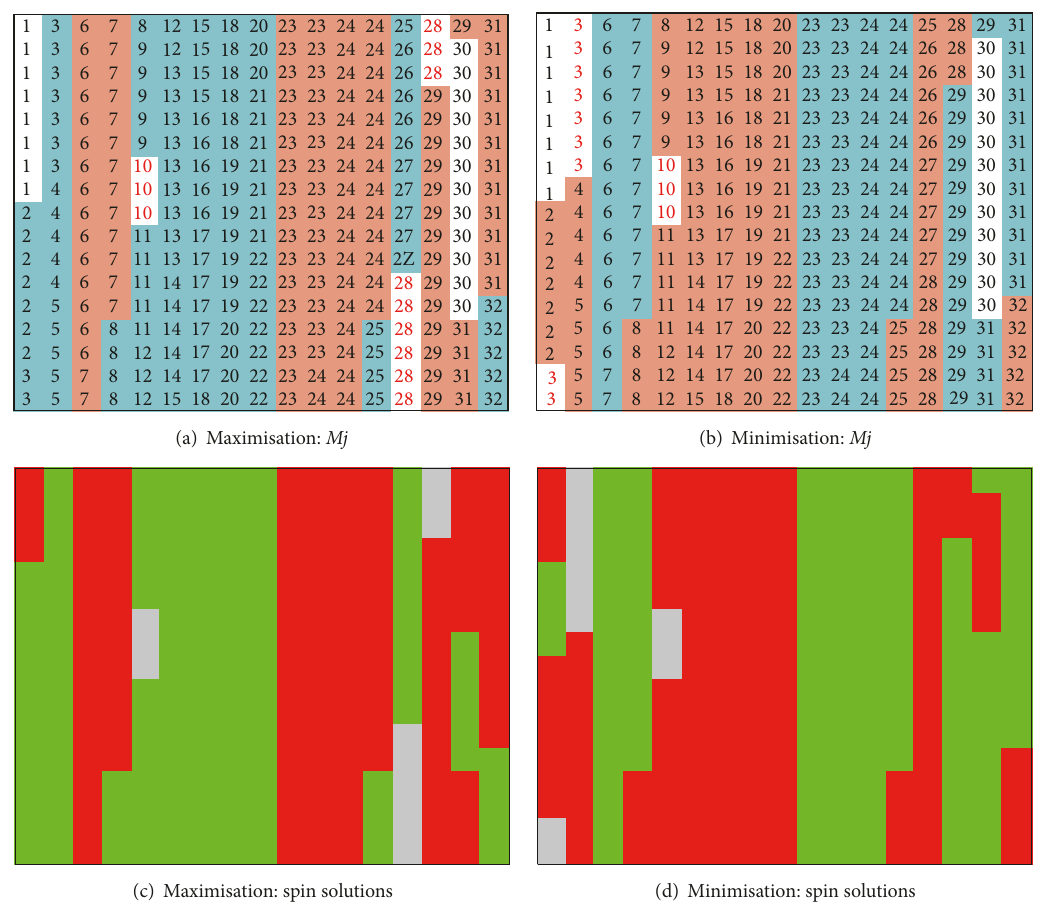
Figure 5: Electrical constraints and spin solutions in a self-sustainability scenario. (a, b) Max/min solutions with 𝑀 𝑗 = −1 (red), 𝑀 𝑗 = 0 (white), and 𝑀 𝑗 = 1 (blue); numbers indicate the bus number the customers belong to. (c, d) Spin solutions with 𝛾 𝑗𝑡 = −1 (red), 𝛾 𝑗𝑡 = 1 (green), and grey color if there is no